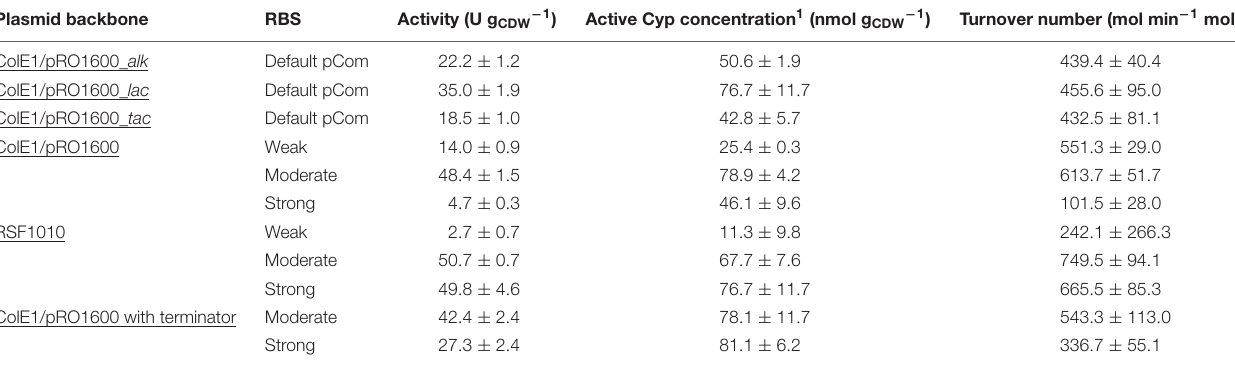
TABLE 2 | Specific whole-cell activities, Cyp concentrations, and Cyp turnover numbers obtained with the different expression vectors constructed. Plasmid